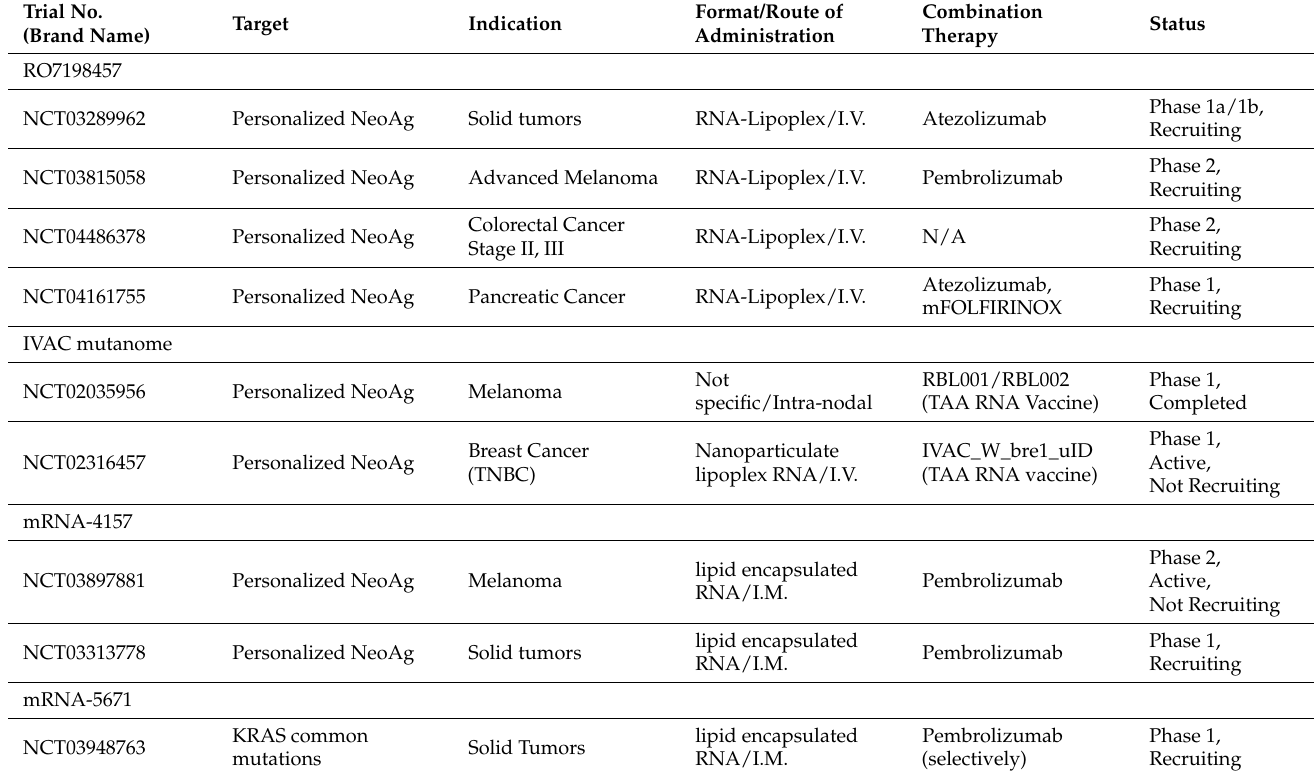
Table 3. Clinical trials of neoantigen RNA